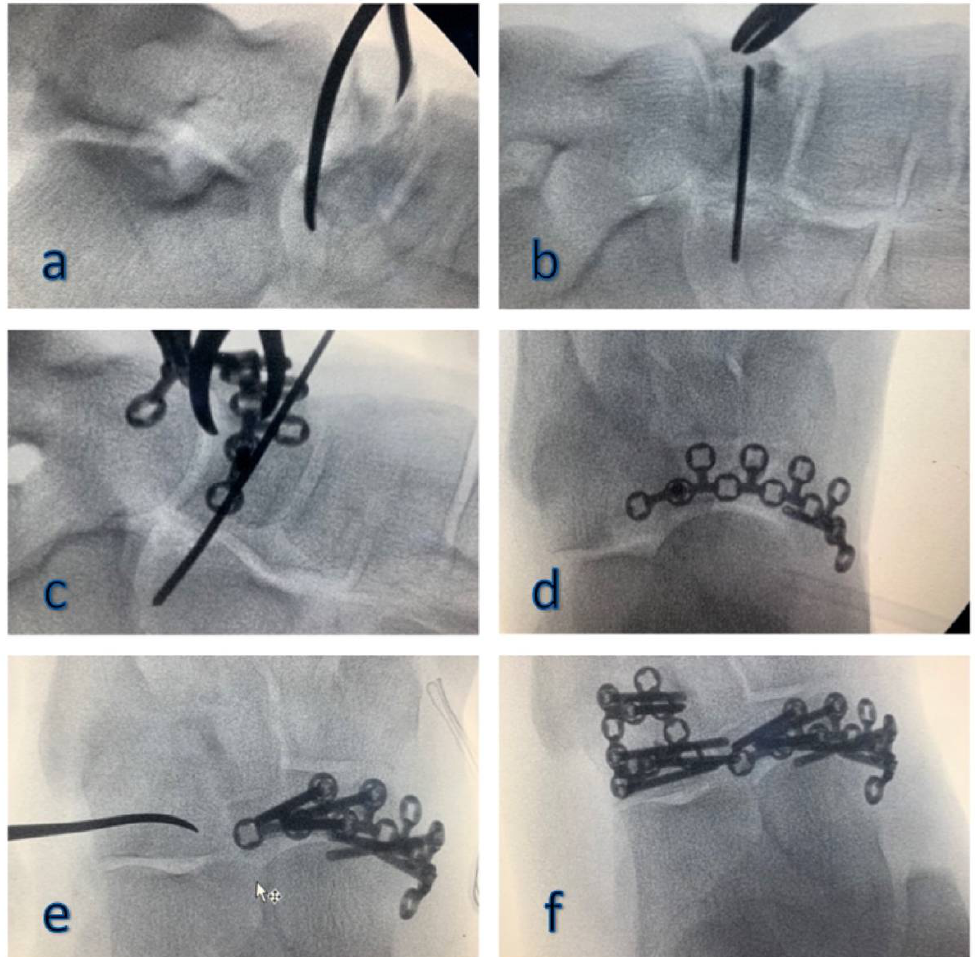
Figure 3. Intraoperative images: reduction ( a ), stabilization ( b ) and synthesis with plate and screws ( c , d ) of the navicular fracture; reduction and synthesis with plate and screws of the cuboid fracture, using the synthetic bone graft to fill the gap ( e , f